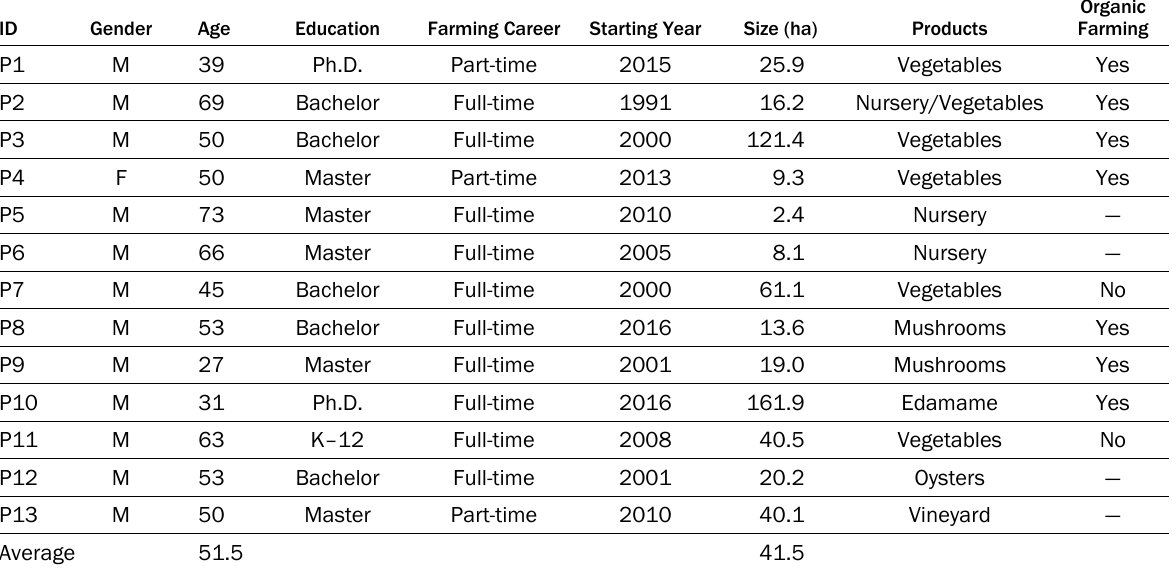
Table 1. Participants and Their Demographics and Farm